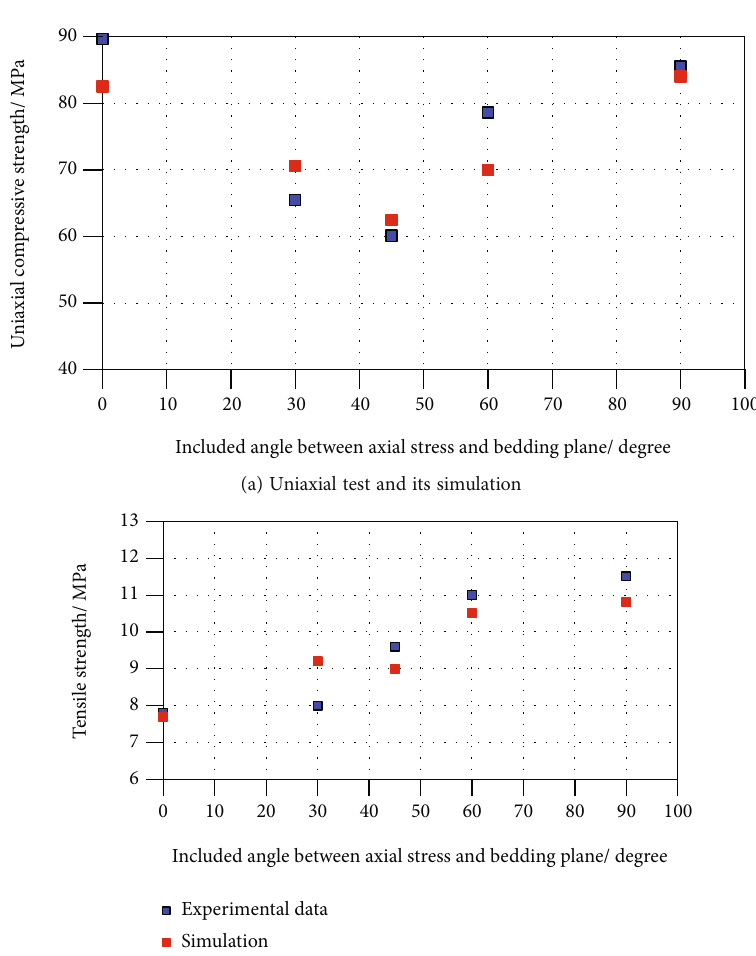
Figure 8: Experimental data and simulation results with input parameters in Table 1.